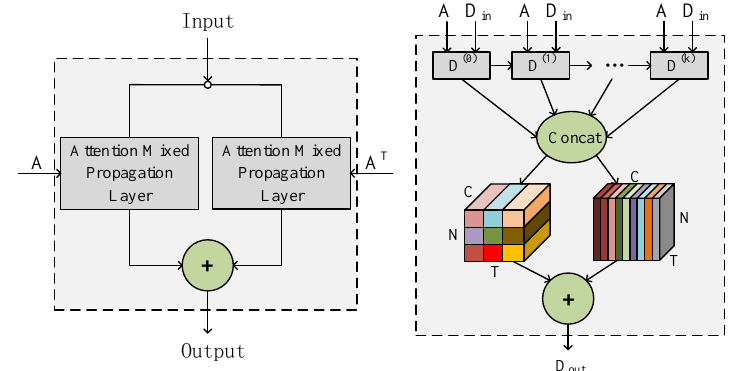
Figure 1. Graph Convolution Module and Attention Mixed